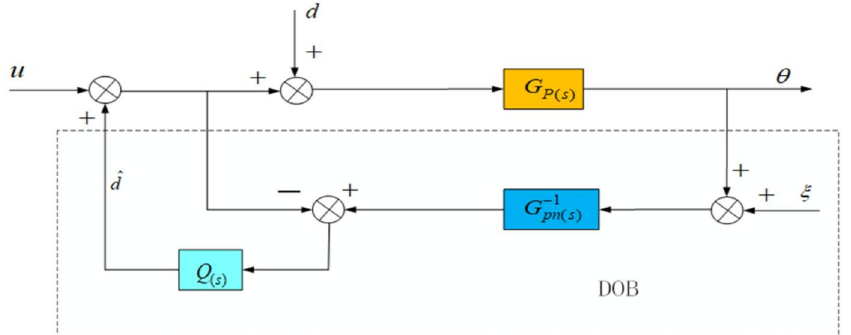
Figure 8. Schematic diagram of interference